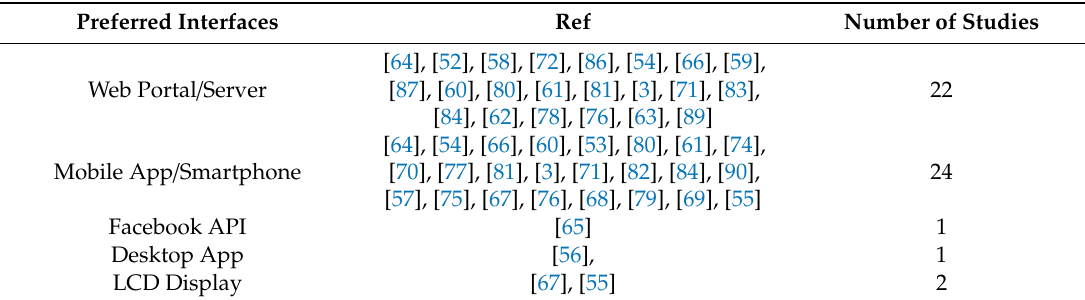
Table 5. Preferred data consulting methods